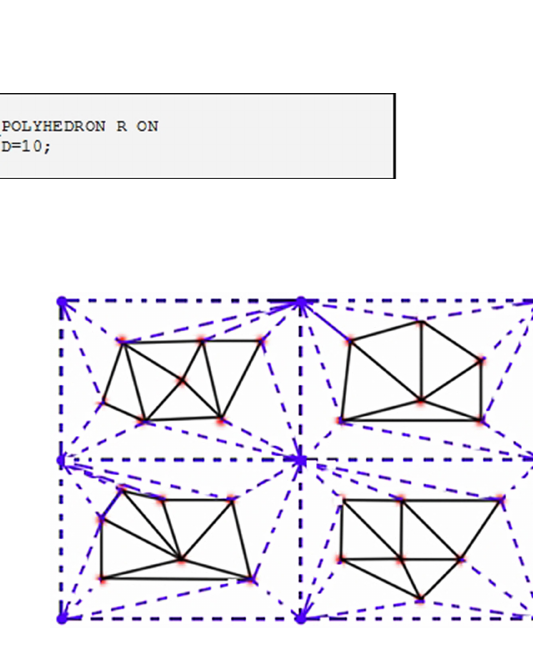
Figure 14. A whole surface model merged with new dotted trian- gles.